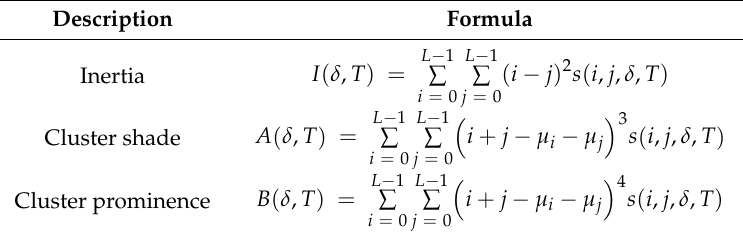
Table A2. Textural features included in the classification as described in